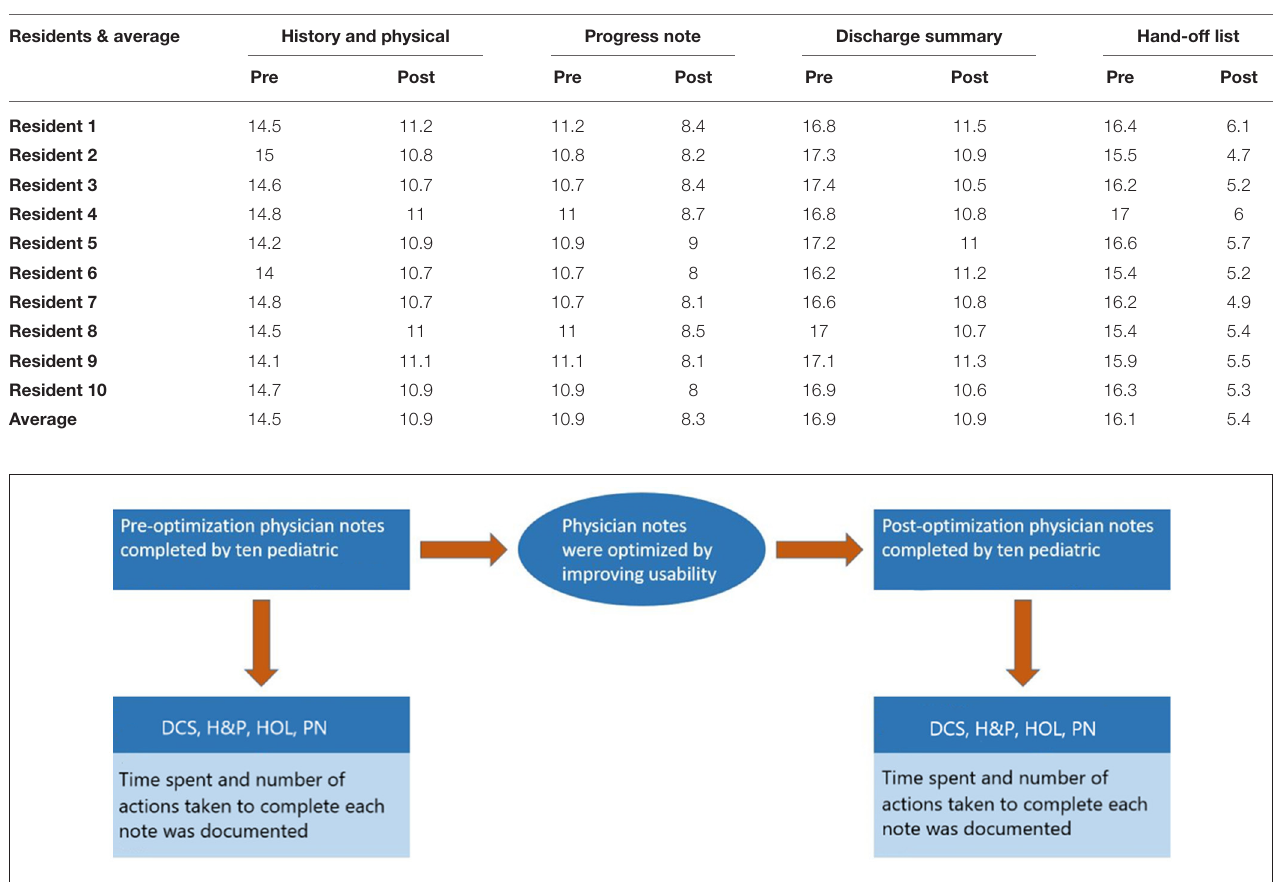
FIGURE 4 | Flowchart of data collection